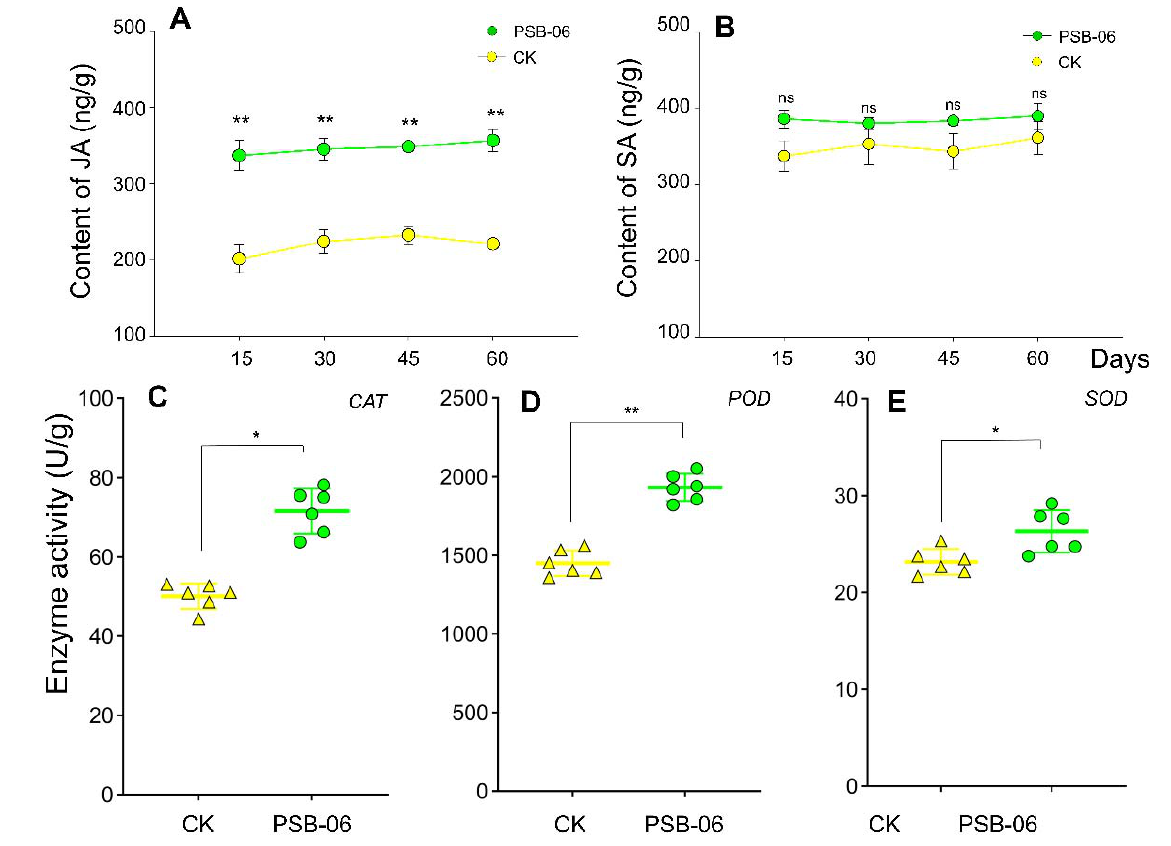
Figure 2. Effect of PSB-06 on plant defense pathways. The content of jasmonic acid (ng/g) in tomato plants at 15, 30, 45, and 60 days ( A ). The content of salicylic acid (ng/g) in tomato plants at 15, 30, 45, and 60 days ( B ). The activity of catalase in tomato plants following treatments of PSB-06 for 45 days ( C ). The activity of peroxidase in tomato plants ( D ). The activity of superoxide dismutase in tomato plants ( E ). CK: The tomato plants treated with water. PSB-06: The tomato plants treated with PSB-06. Data are the mean ± SE; ** p < 0.01; * p < 0.05; ns: Not Significant. SE, standard error; PSB-06, photosynthetic bacteria ‐ 06.